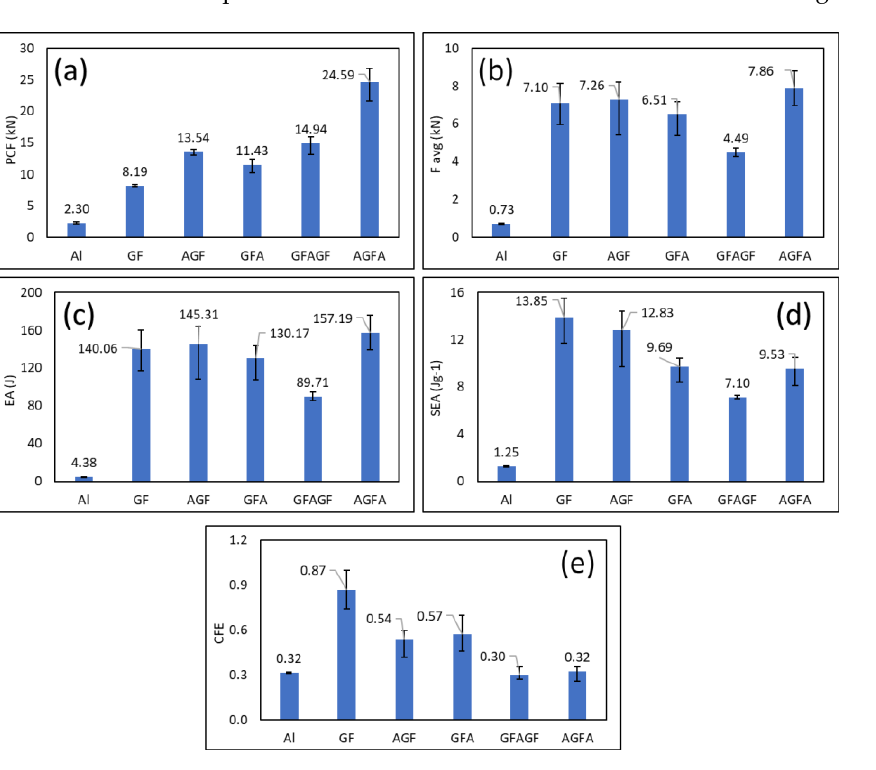
Figure 8. Axial crashworthiness indicators of each specimen load and displacement curve of ( a ) peak crushing force (PCF), ( b ) F average, ( c ) energy absorption (EA), ( d ) specific energy absorption (SEA), ( e ) crush force efficiency (CFE).